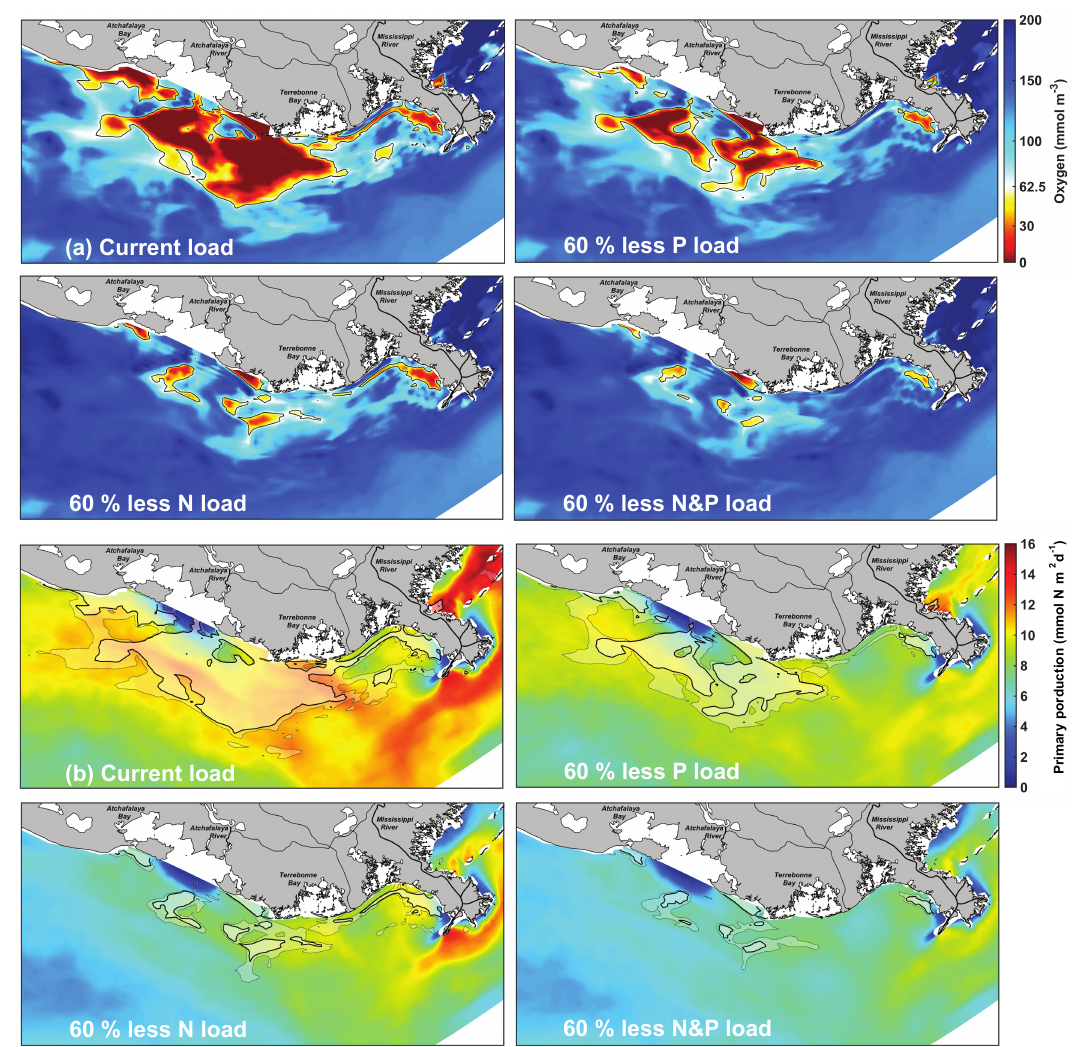
Figure 3. Bottom-water oxygen on 28 July 2009 (the day of maximum simulated hypoxic extent in 2009) for the simulations with current nutrient load, 60% reduction in DIP load, 60% reduction in TN load, and 60% in both (same simulations as shown in Fig. 2), and primary production averaged over May, June and July in 2009. The bold black lines in the bottom panels outline the hypoxic zones ( < 2mgO 2 L − 1 ) shown in the top panels, and the thin lines outline the area with < 3mgO 2 L − 1